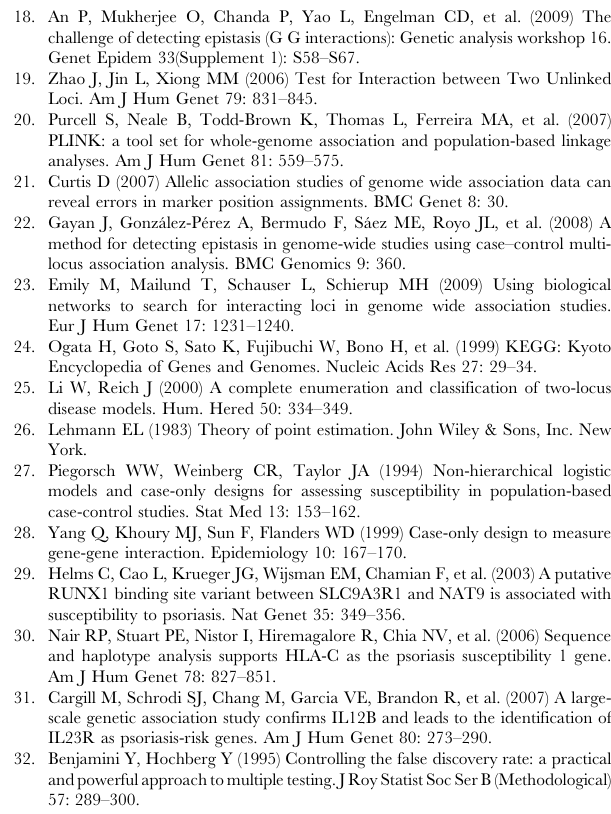
Table S1 A total of 44 pairs of SNPs showing significant interaction with FDR less than 0.001 in two independent studies.